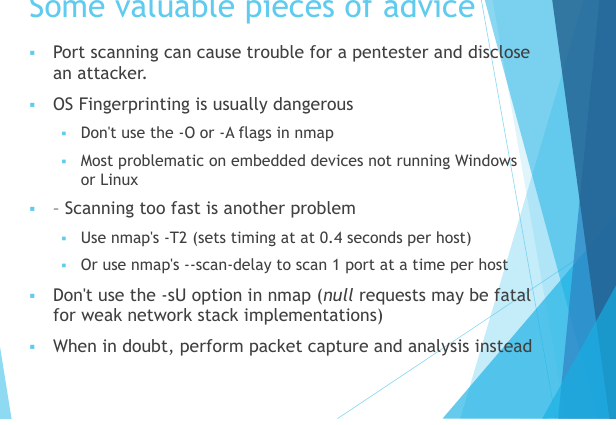
Figure 14. Good practices for ICS pentesting and scouting